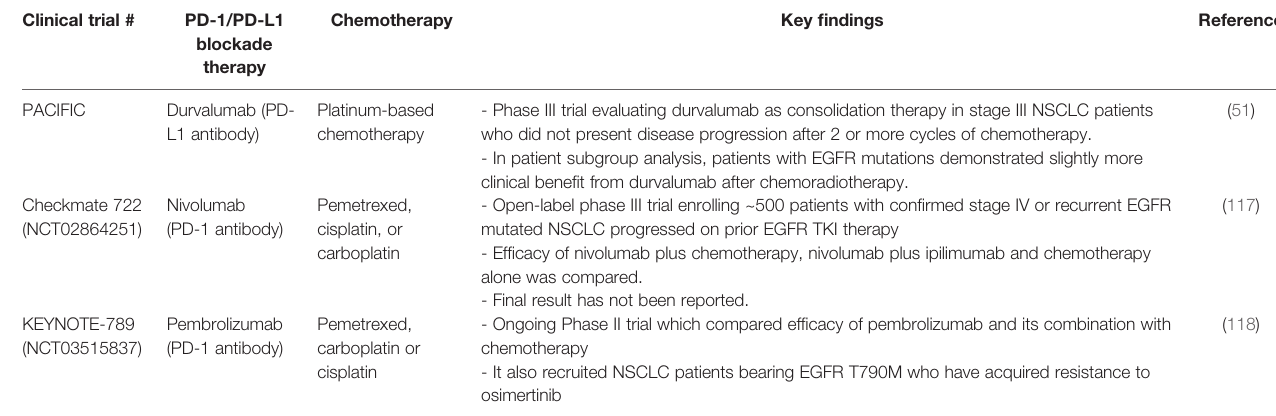
TABLE 2 | Representative clinical trials evaluating the combination of PD-1/PD-L1 blockade immunotherapy and conventional chemotherapy in EGFR-mutant NSCLC